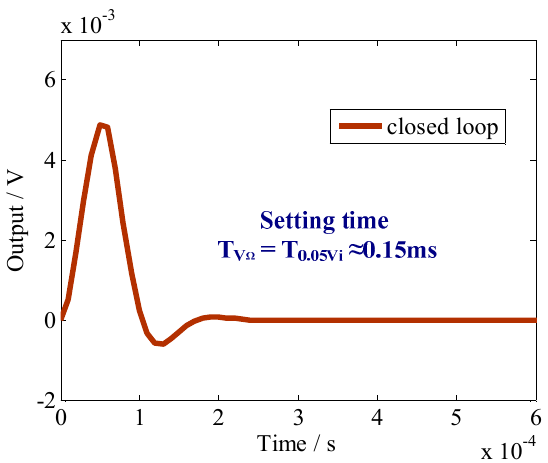
Figure 6. Time-domain response of the sense-mode closed-loop output.